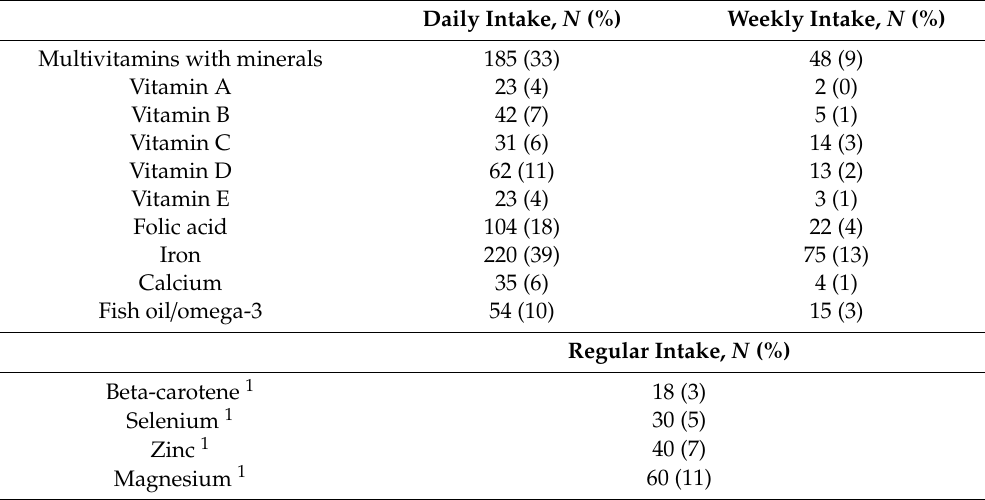
Table 5. Numbers of study participants reporting intake of